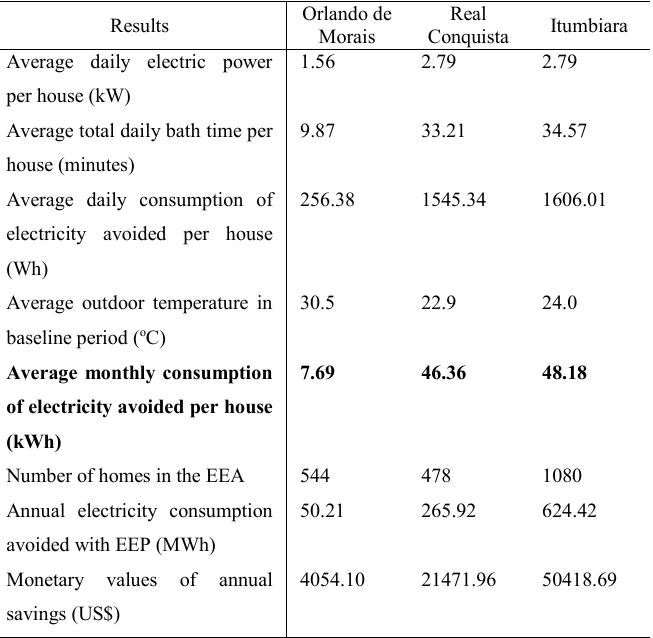
TABLE II R ESULTS OF E LECTRICITY S AVING IN EEP A